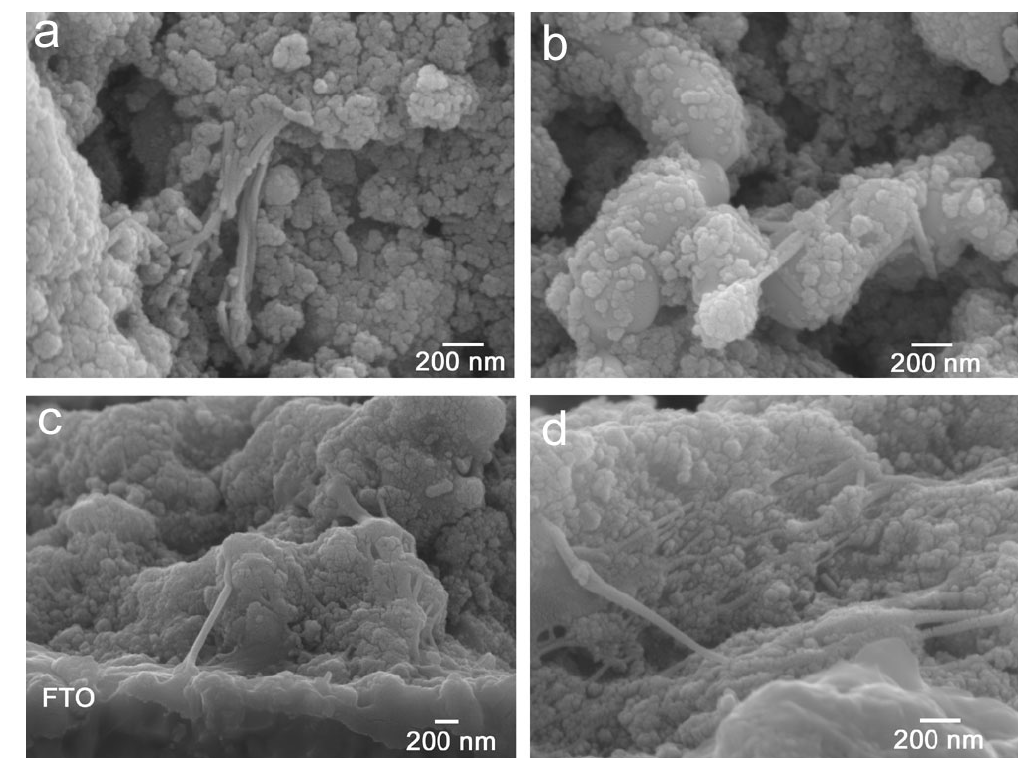
Fig. 6 (a, b) Top views and (c,d) cross sectional views of the partially nanowire-structured dye-sensitized solar cell